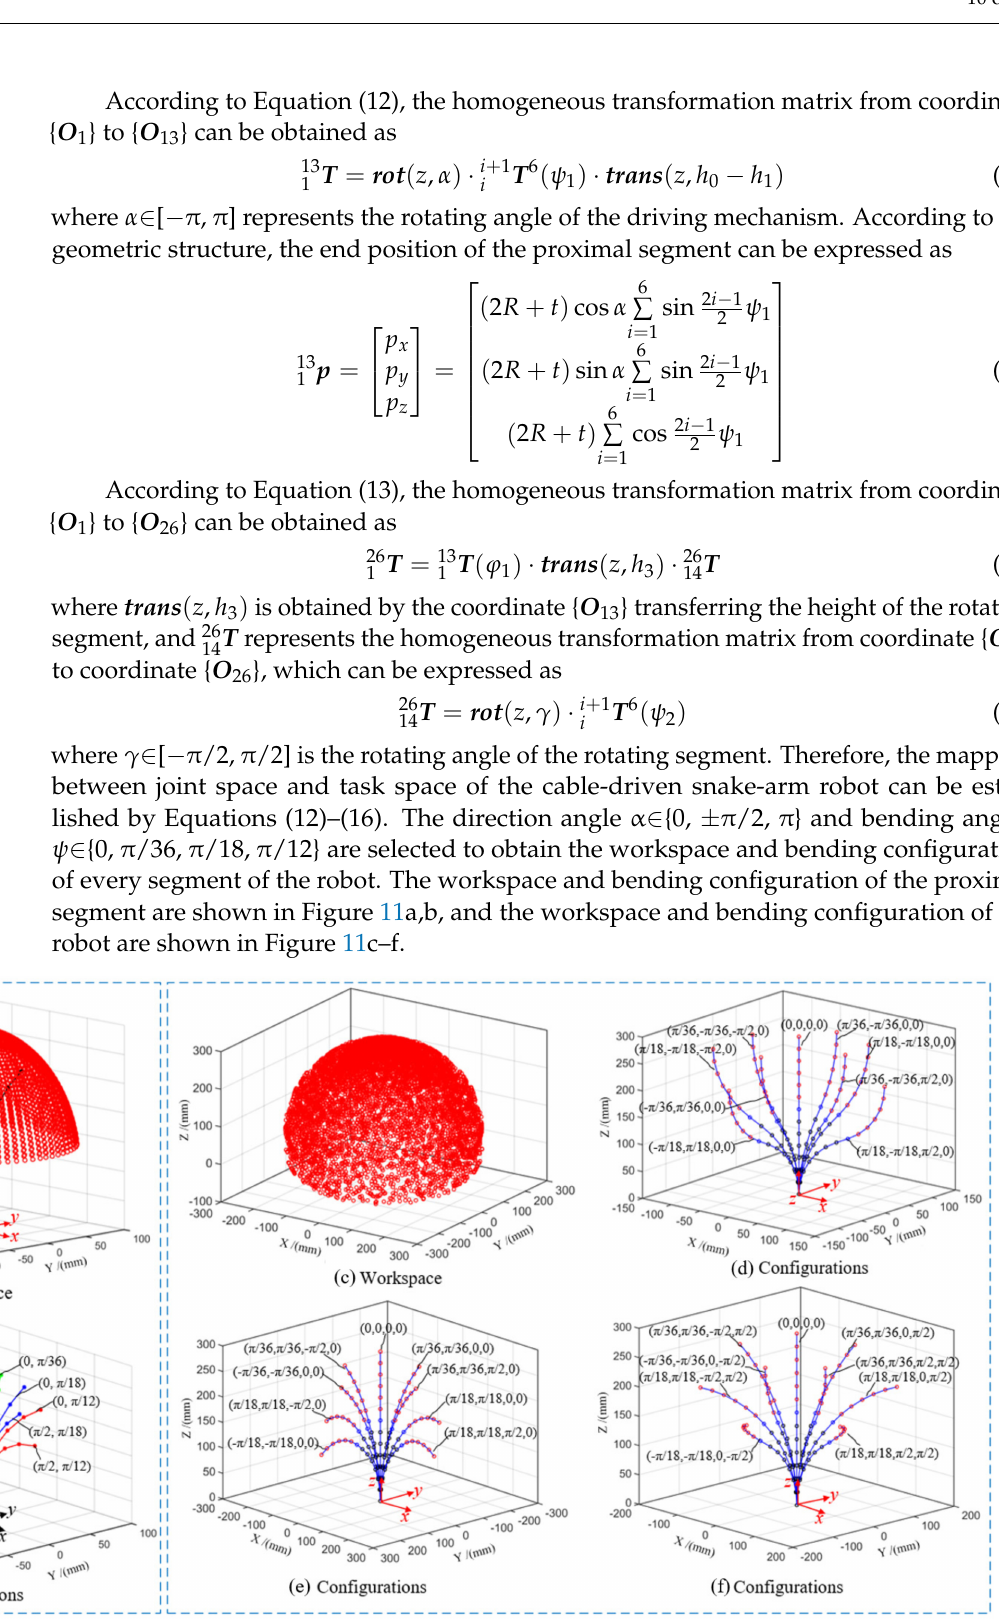
Figure 11. The workspace and bending configurations of the robot. ( a ) The workspace of the proximal segment. ( b ) The configurations of the proximal segment. ( c ) The workspace of the robot. ( d ) The bending configuration in different direction. ( e ) The bending configuration in same direction. ( f ) The bending configuration in different bending